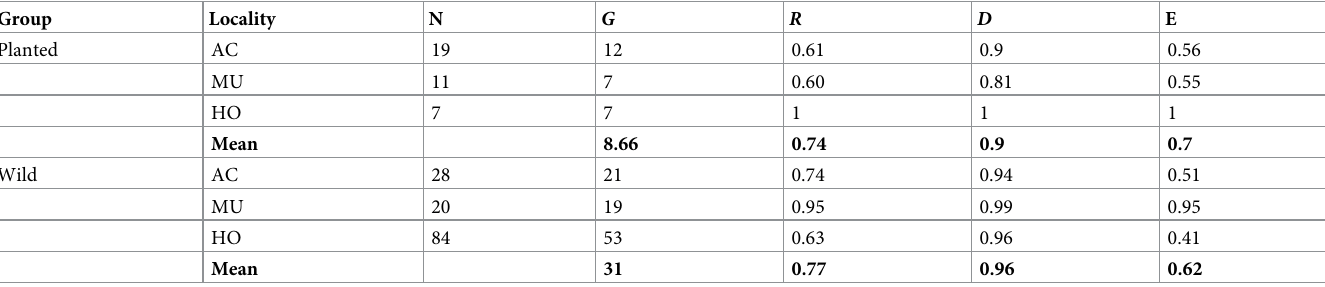
Table 2. Clonal diversity parameters of adult trees in wild and planted stands of Spondias purpurea . Group Locality